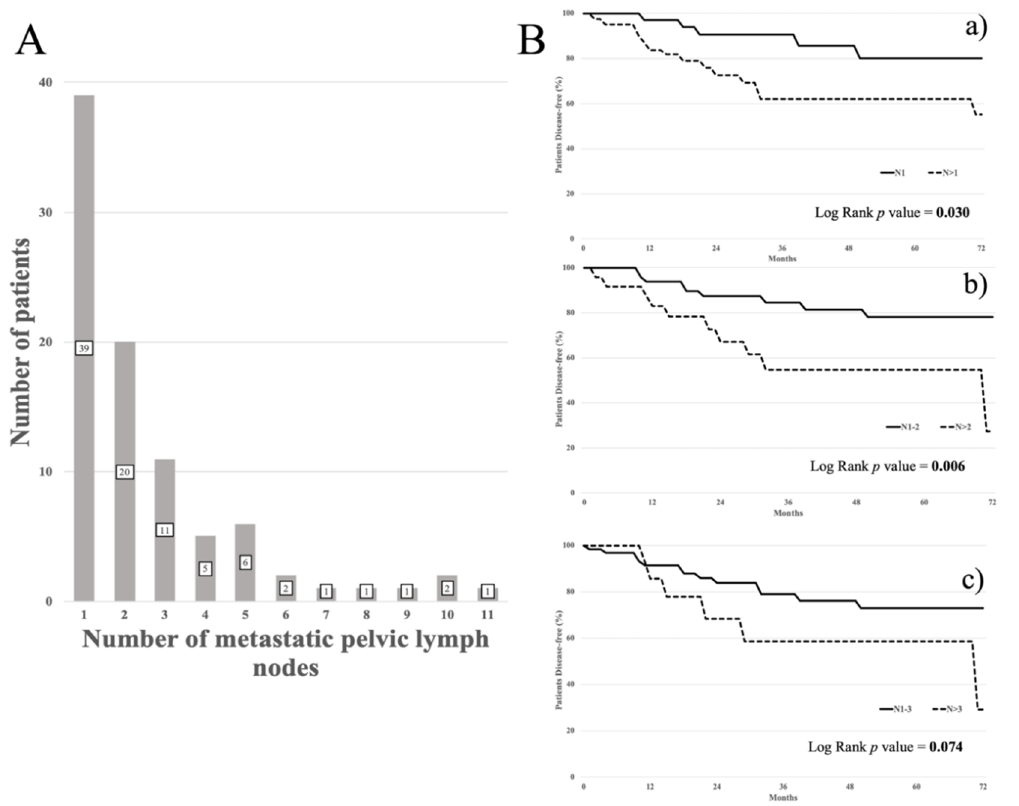
Figure 2. ( A ) Distribution of the number of metastatic pelvic lymph nodes per patient. ( B ) Disease free survival according to the cut o ff value of the number of metastatic pelvic lymph nodes representing the 25th (panel a), 50th (panel b), 75th (panel c) percentiles.